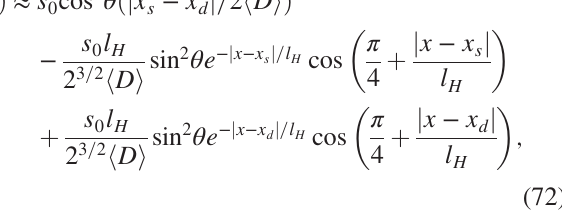
ffiffiffiffiffiffiffiffiffiffiffiffiffiffiffiffiffiffiffiffiffiffiffi p ffiffiffiffiffiffiffiffiffiffi 2 ℏ h D i = h Δ i